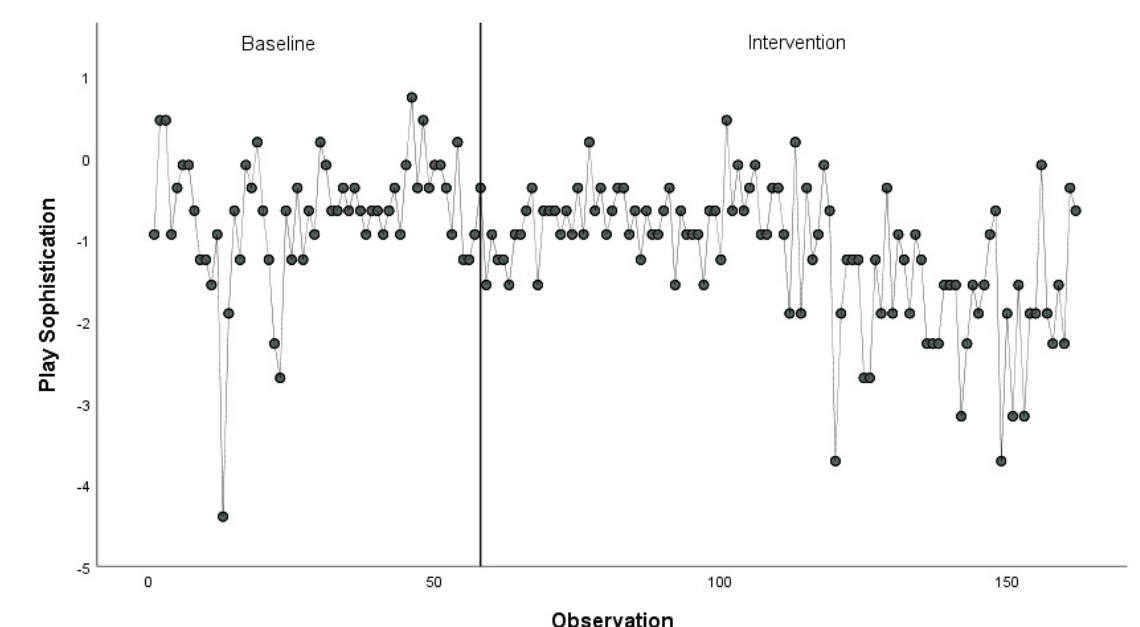
Figure 1. Playground observation scores during baseline and intervention at School A.